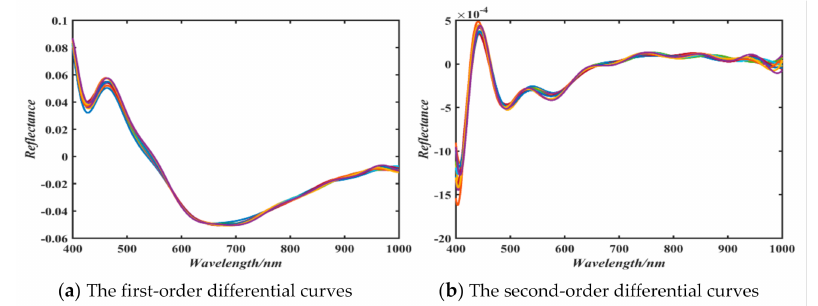
Figure 4. The first and second-order differentials pre-processing.